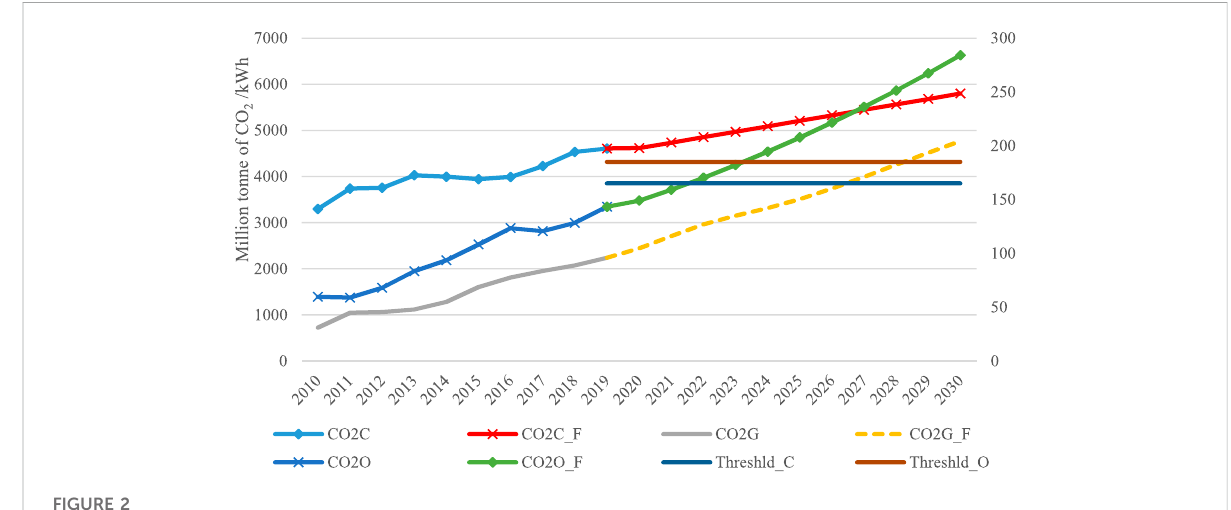
FIGURE 2 Predicted trends of CO 2 emissions created by different power plants during 2020 –